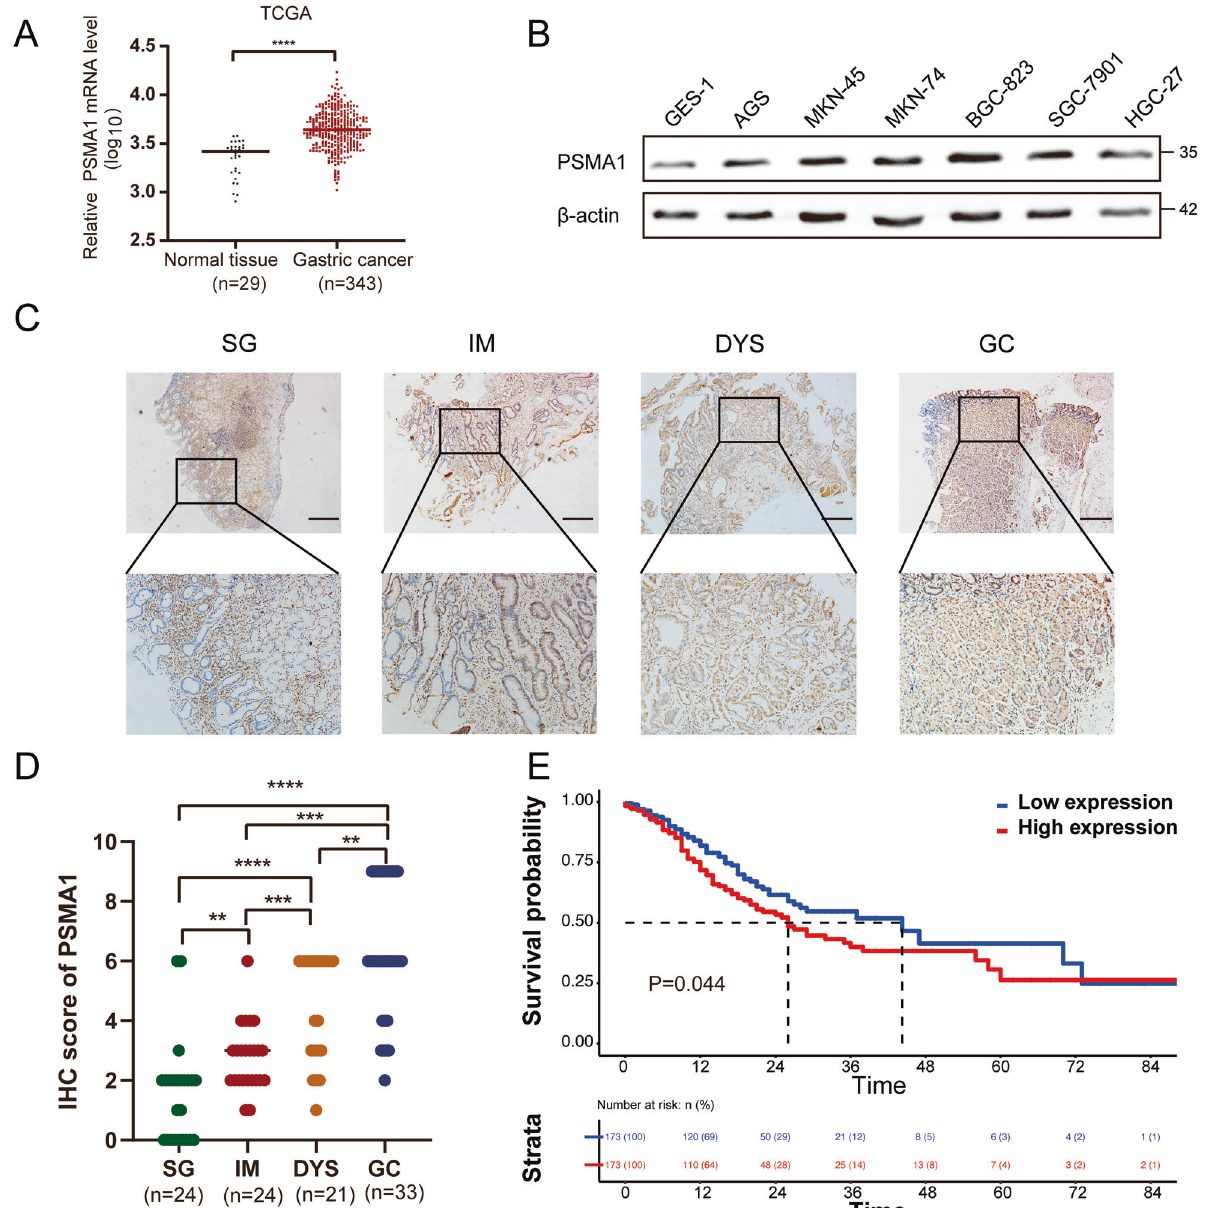
Fig. 1 PSMA1 was elevated in gastric cancer. A The real-time PCR assay of the mRNA expression of PSMA1 in gastric cancer tissue and normal tissue is based on the data from the TCGA database. B The basic PSMA1 protein level in different gastric cancer (GC) cell types. C Immunohistochemistry (IHC) staining for PSMA1 in super fi cial gastritis (SG), intestinal metaplasia (IM), dysplasia (DYS), and GC samples. Bar length: 100 μ m. D IHC score analyzed the expression levels of PSMA1 in SG, IM, DYS, and GC. E The Kaplan – Meier plot of overall survival by the expression of PSMA1 in the GC patients, the data was carried out from the TCGA